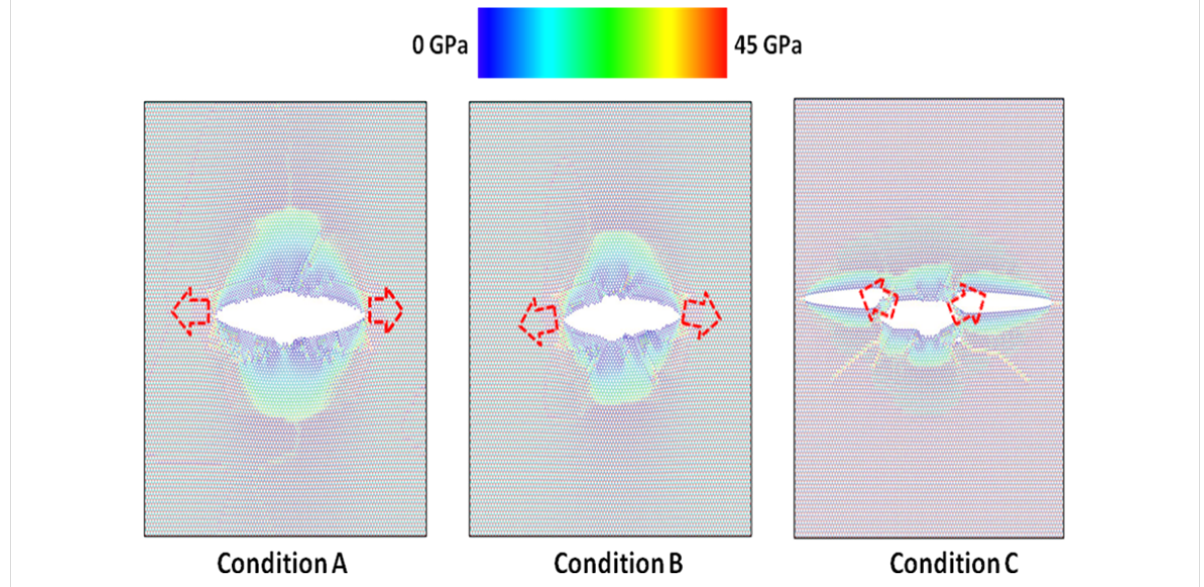
Figure 8: The maximum principal stress distribution after crack extension for three crack tip types.